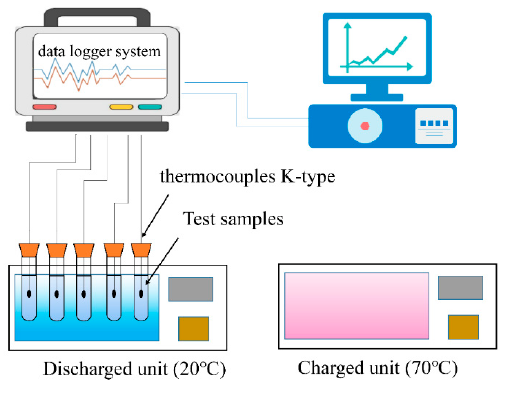
test system consists mainly of two water baths (high-temperature, low-temperature), a